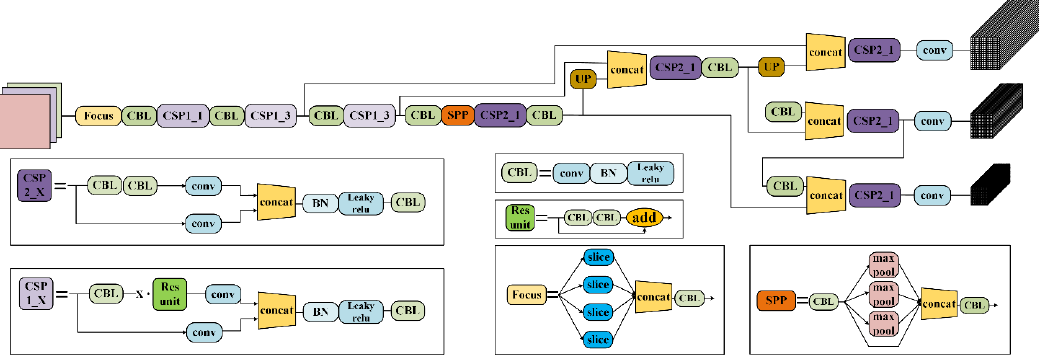
Figure 5. The overall structure of yolov5s.